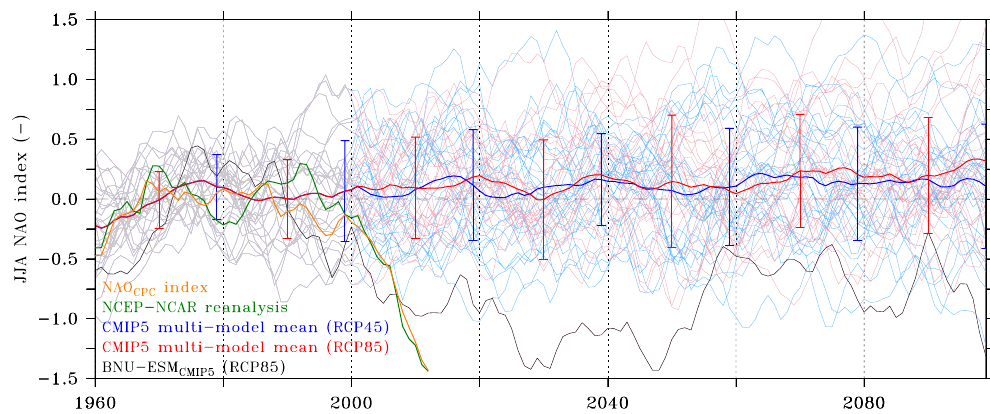
Fig. 4. Time series (10-yr running mean) of the JJA NAO index over 1960–2100. For the NCEP-NCAR reanalysis (in green) and the General Circulation Models (GCMs) from the CMIP5 database, the JJA NAO index is estimated as the standardized (over 1961–1990) difference of the JJA mean sea-level pressure between the Azores (27 ◦ W, 39 ◦ N) and Southwest Iceland (22 ◦ W, 64 ◦ N). For the CMIP5 GCMs, the historical scenario (in grey) is used for recent (1960–2005) climate conditions and future projections over 2006–2100 use RCP 4.5 (in blue) and RCP 8.5 (in red) scenarios (Moss et al., 2010). The CMIP5 multi-model mean (composed of 28 GCMs) as well as the standard deviation of the ensemble mean are also plotted in dark blue and red, respectively. The NAO time series simulated by the Chinese model BNU-ESM (using RCP8.5) is plotted in black. Finally, the JJA NAO index from CPC is plotted in orange for